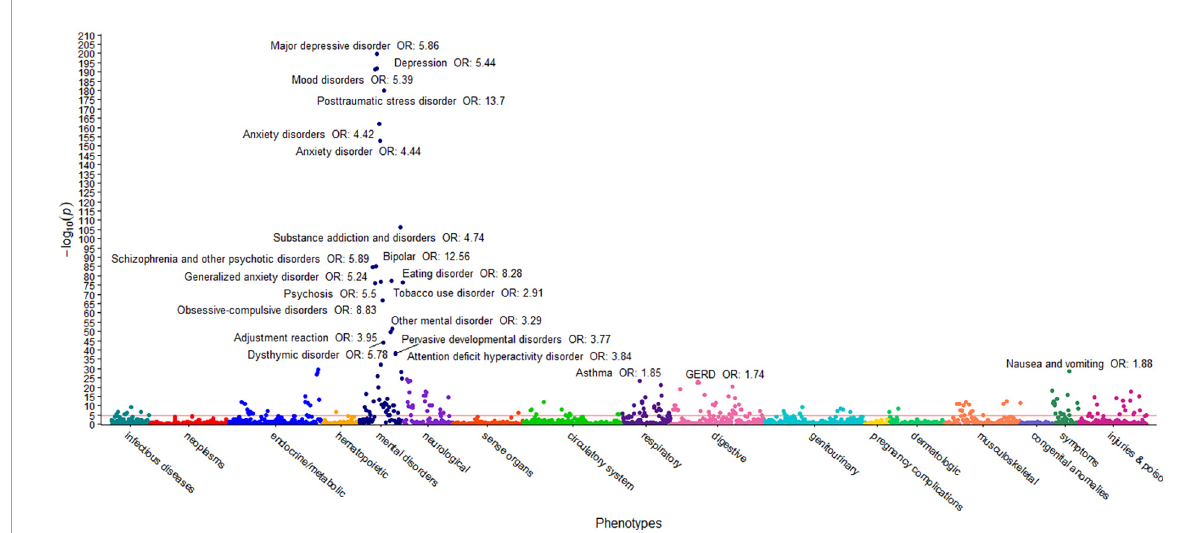
FIGURE1 ACEs PheWAS Dose-response ICD10 only. This figure illustrates the results of 1,447 individual associations between the ACE score and the incidence of phenotype group (phecode) of the HNP ACE cohort. Covariates included in the models are sex and age at genotyping. Each point denotes the p -value of association of that phenotype. The red horizontal line represents the Bonferroni-corrected significance level of α = 3.5 × 10 − 5 . Only associations with p < 1 × 10 − 20 are annotated for ease of viewing.